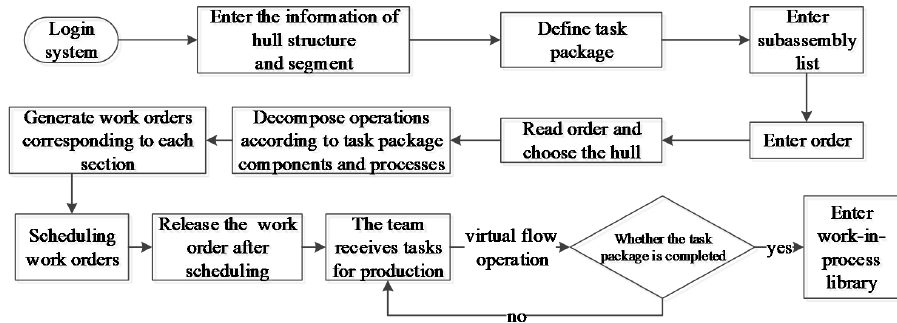
Figure 8. The scheduling process of lean shipbuilding.